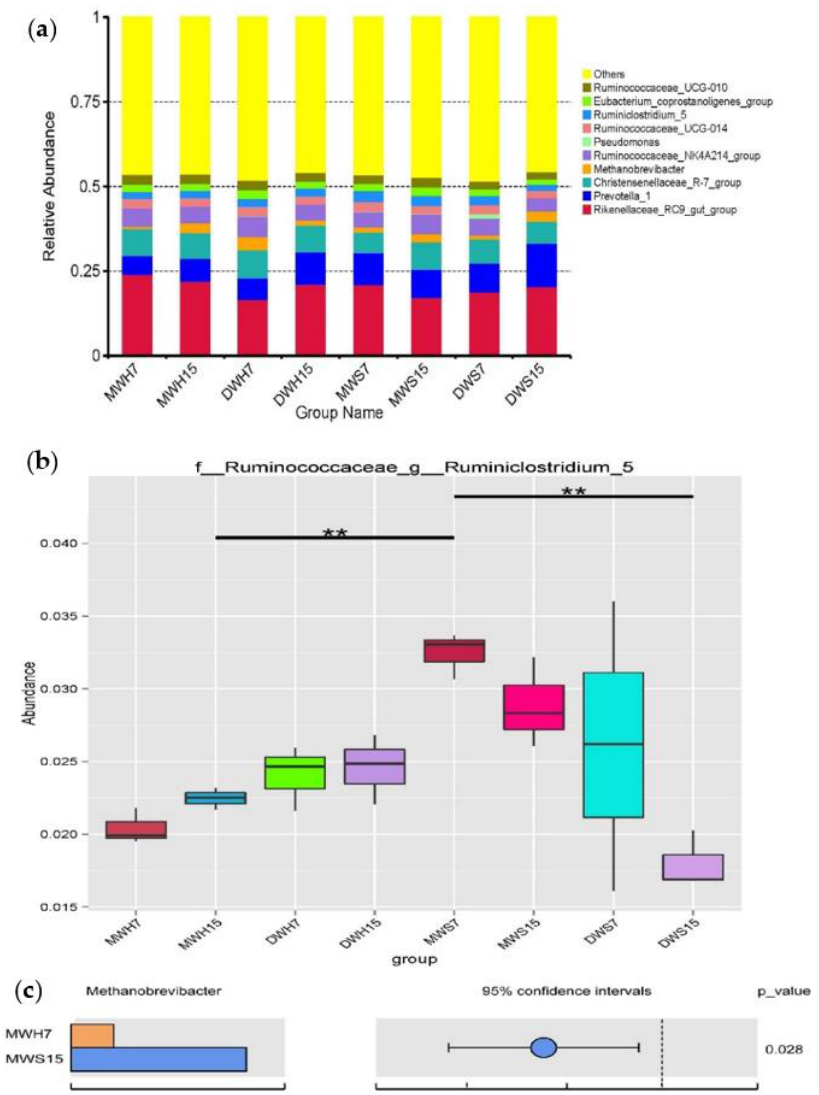
Figure 4. Bacterial community barplot analysis at the genus level in anaerobic fermentation of different treatments. ( a ) The relative abundance of the top 10 genera of rumen microbial community among treatments; ( b ) The differences of the genus Ruminiclostridium _5 among the treatments; ( c ) The differences of the genus Methanobrevibacter between the groups. MWH7 = wheat harvested at 7:00 in milk stage and preserved as hay; MWS7 = wheat harvested at 7:00 in milk stage and preserved as silage; DWH7 = wheat harvested at 7:00 in dough stage and preserved as hay; DWS7 = wheat harvested at 7:00 in dough stage and preserved as silage; MWH15 = wheat harvested at 15:00 in milk stage and preserved as hay; MWS15 = wheat harvested at 15:00 in milk stage and preserved as silage; DWH15 = wheat harvested at 15:00 in dough stage and preserved as hay; DWS15 = wheat harvested at 15:00 in dough stage and preserved as silage. ** p < 0.01.